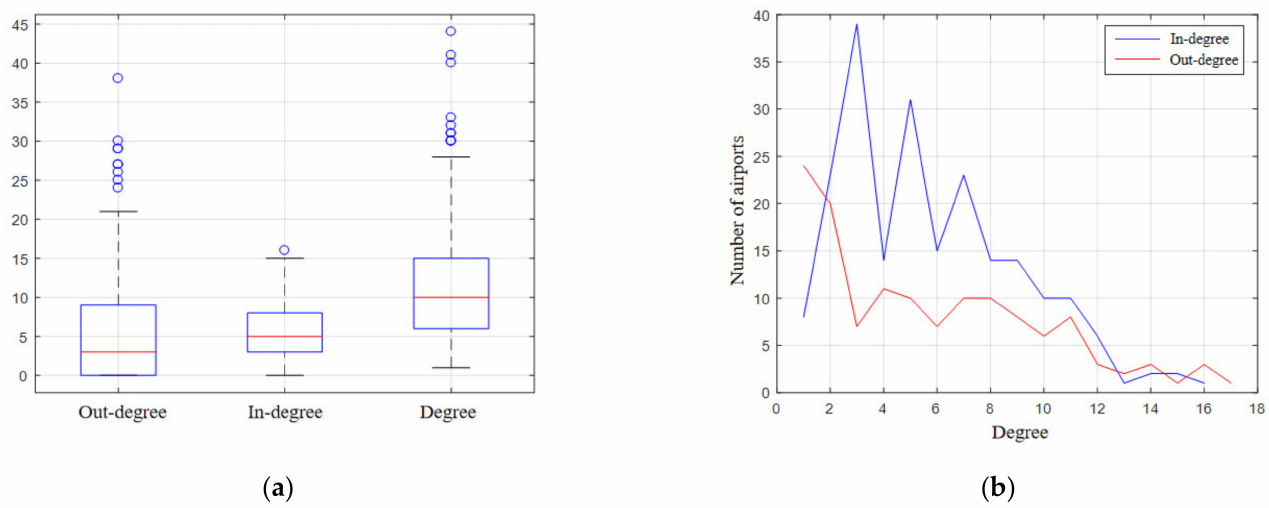
Figure 16. Degree distribution. ( a ) Box plot of out-degree, in-degree, and degree, ( b ) Number of airports with different in-degree and